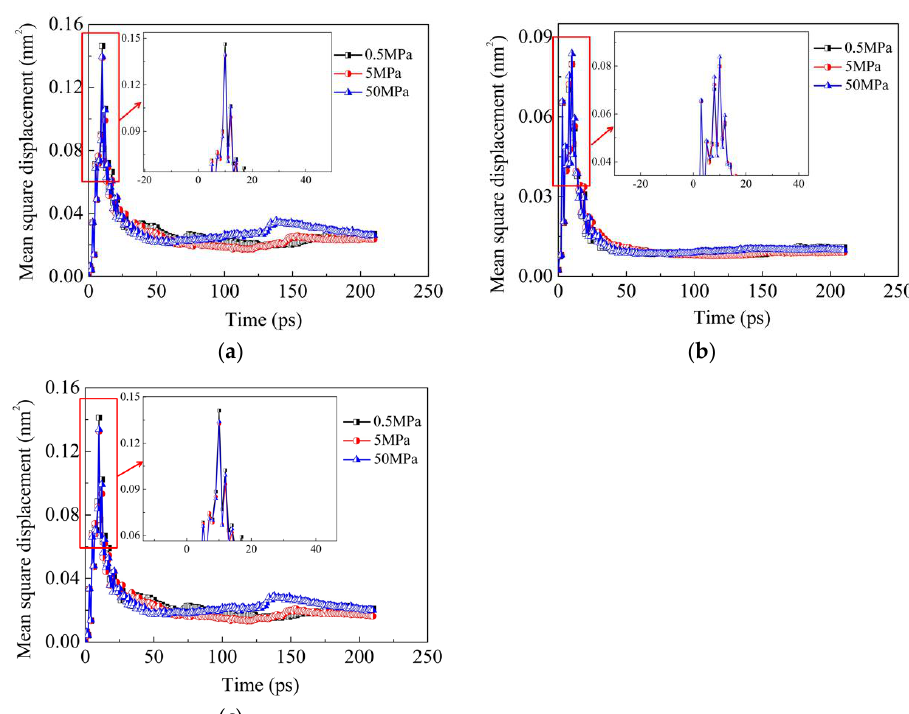
Figure 8. Influence of vertical pressure on the diffusion configuration of model Ι at 1200 K: ( a ) 0.5 MPa; ( b ) 5 MPa; ( c ) 50 MPa.